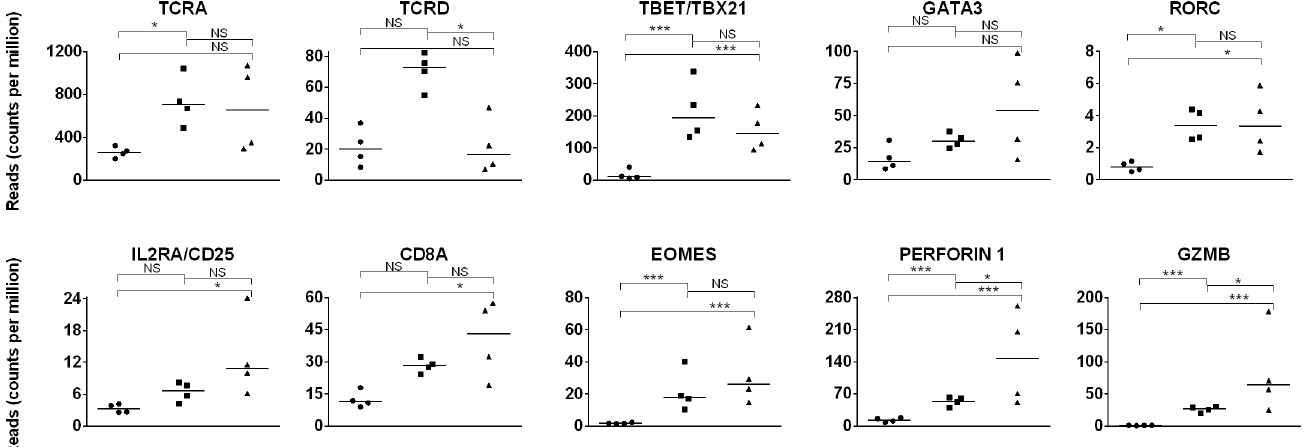
Fig 5. T cell gene expression in day 1 foal, day 42 foal, and adult horse samples. Expression (quantified by number of reads on y-axis) of T lineage genes on day 1 foal (circle), day 42 foal (square), and adult (triangle) samples are plotted on the x-axis. The significance level of comparisons is indicated by asterisks ( (cid:3) p < 0.05; (cid:3)(cid:3) p (cid:20) 0.001; (cid:3)(cid:3)(cid:3) p (cid:20) 0.0001); comparisons that did not differ statistically are labeled “NS” to denote not